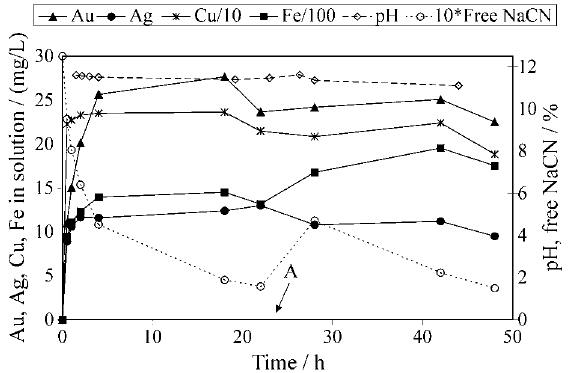
Figure 7. Product leaching using 2.67% thiourea solution; 1 kg of roasted product, 3 L of solution, 20 mL H 2 SO 4 . Au recovery = 71.9%; Ag recovery =